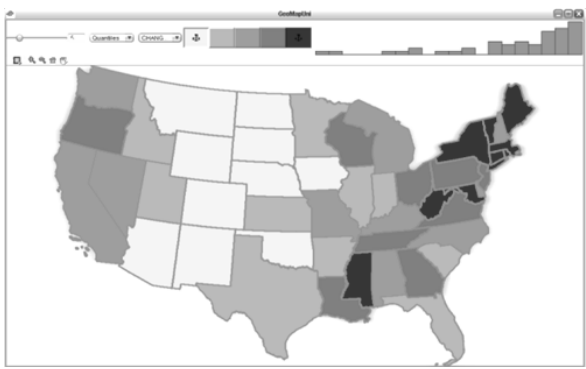
Figure 2: Proportion of relative direction vs. cardinal direction usage for expressing change of direction in the U.S. (Dark: more relative direction usage; light: more cardinal direction usage)